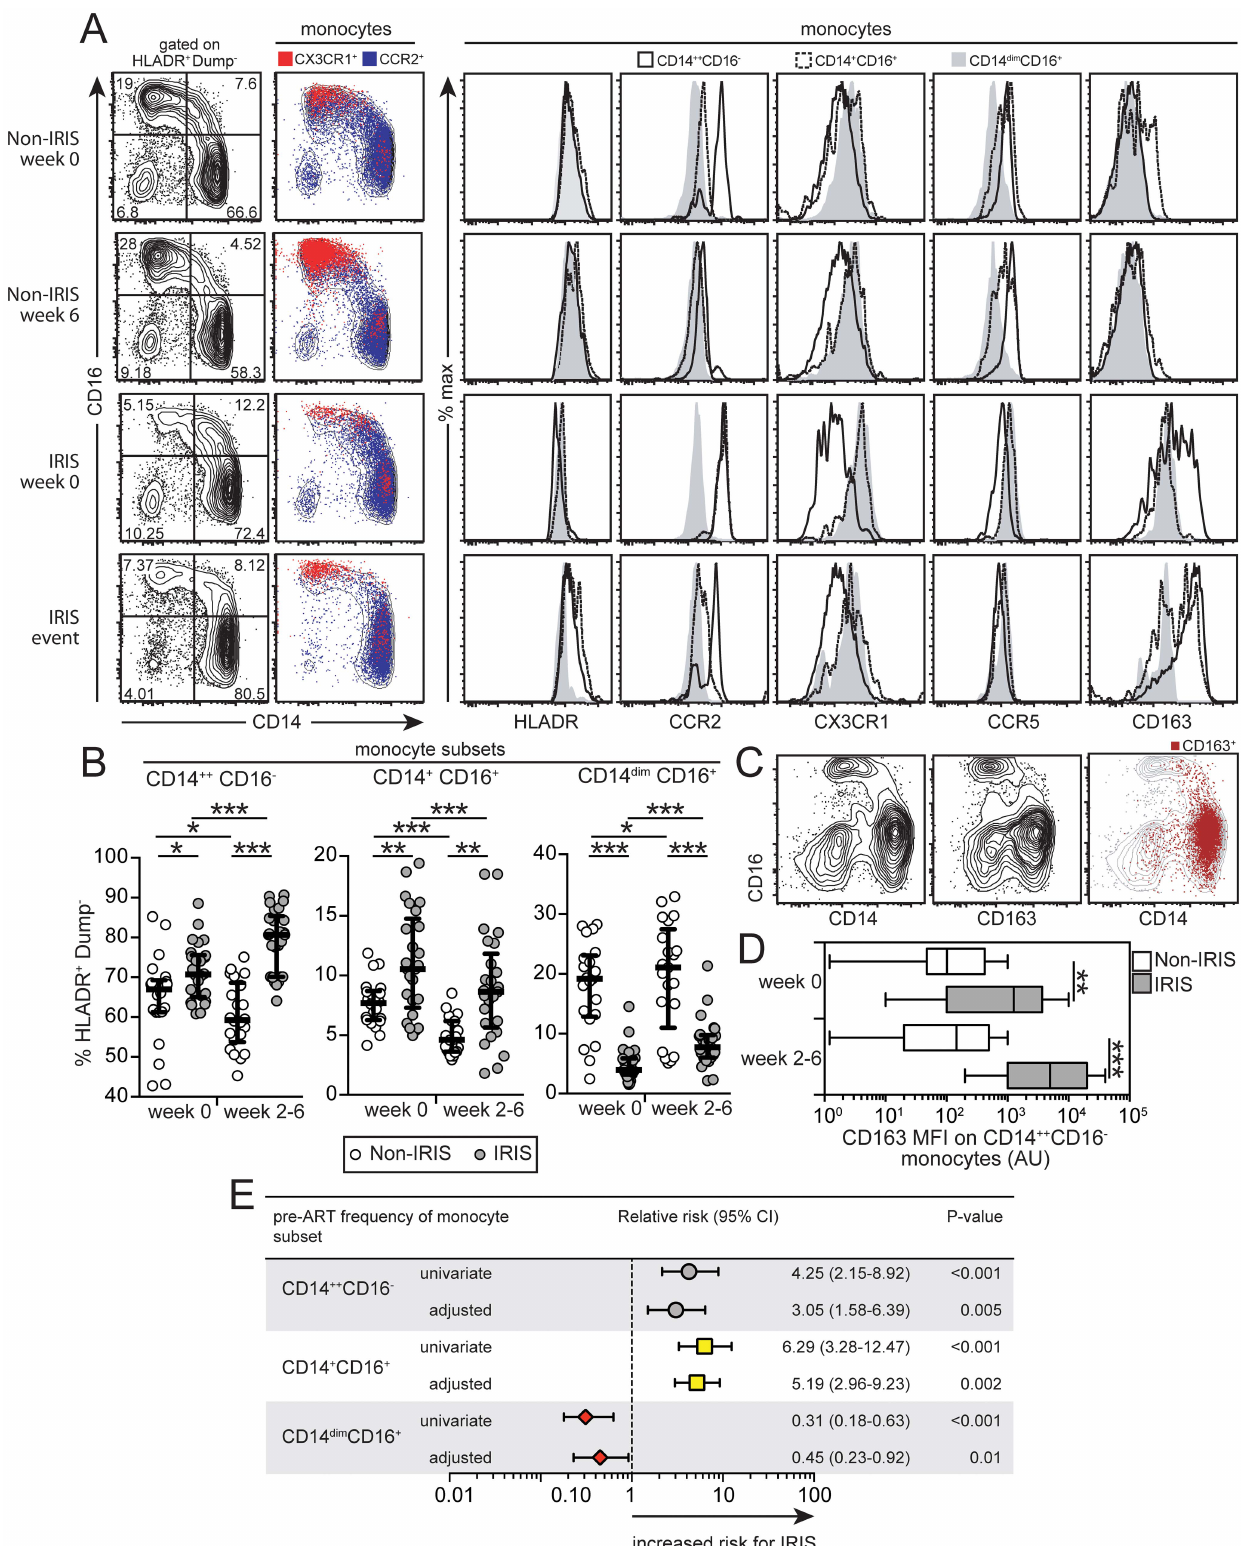
Figure 5. Dynamics of circulating monocyte subsets in TB-HIV co-infected patients following ART initiation. ( A ) Left panel: Representative FACS plots showing the distribution of the monocyte subsets defined by CD14 and CD16 markers at week 0 and at week 6 or time of IRIS in IRIS vs. non-IRIS patients. Monocytes were also defined according to expression of CCR2 and CX3CR1 and overlaid onto CD14 vs. CD16 graphs. Right panel: Representative FACS plots showing histograms of various phenotypic markers in monocyte subsets based on CD14 and CD16 expression